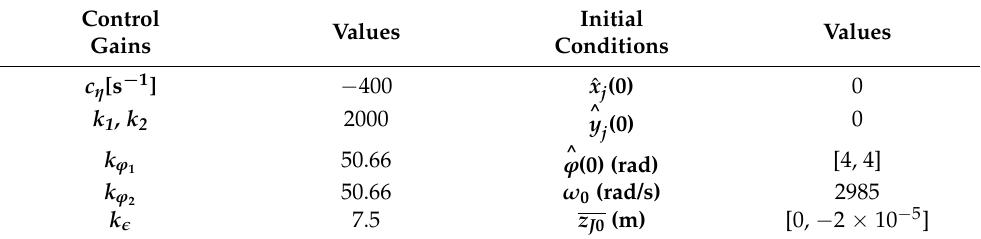
Table 3. Control